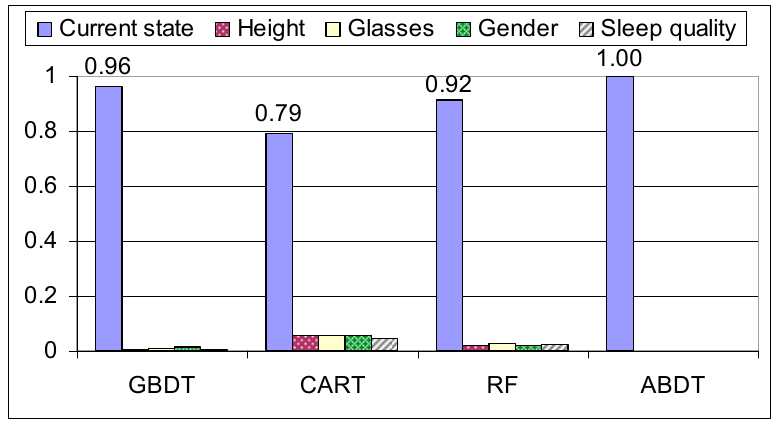
Figure 10. Feature importance on the mixed dataset.